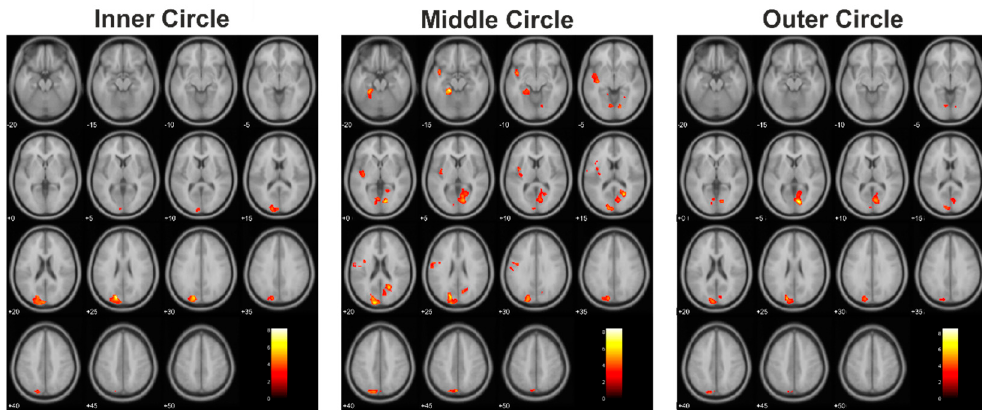
Figure 5. The resulting statistically significant differences of the comparison of the controls > lesion patients.